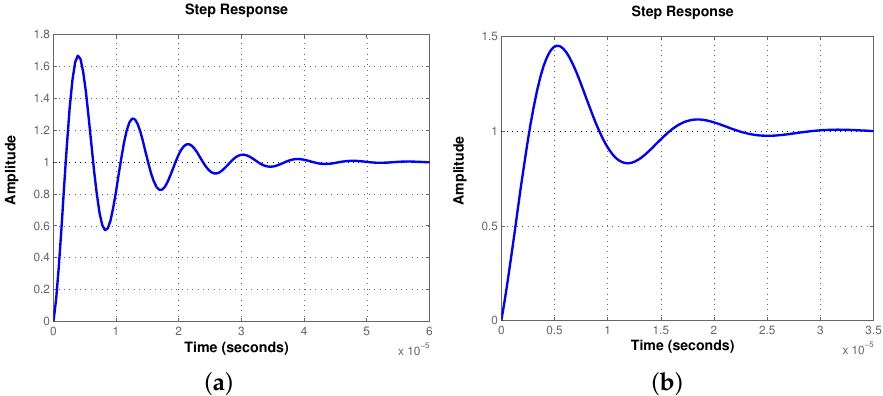
Figure 10. Step response of the closed-loop transfer function of a Buck converter by using typical PID controllers. ( a ) PID controller designed in frequency domain. ( b ) PID controller designed to ensure stability.